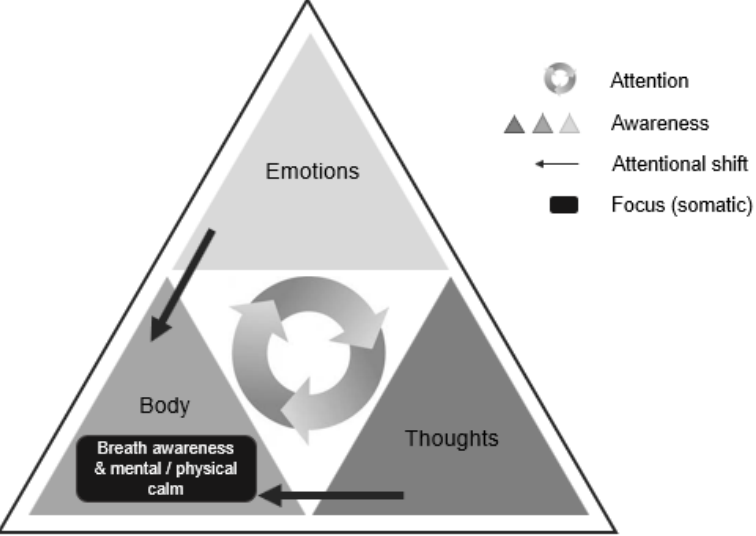
Figure 1. Model of regulatory strategies implemented by adolescents.